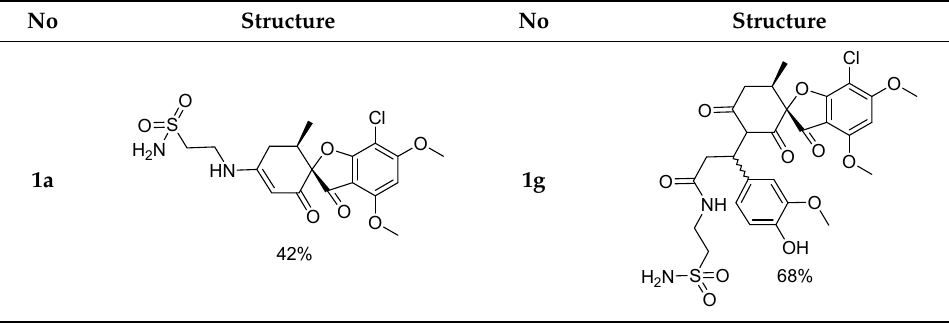
Table 1. Structures of